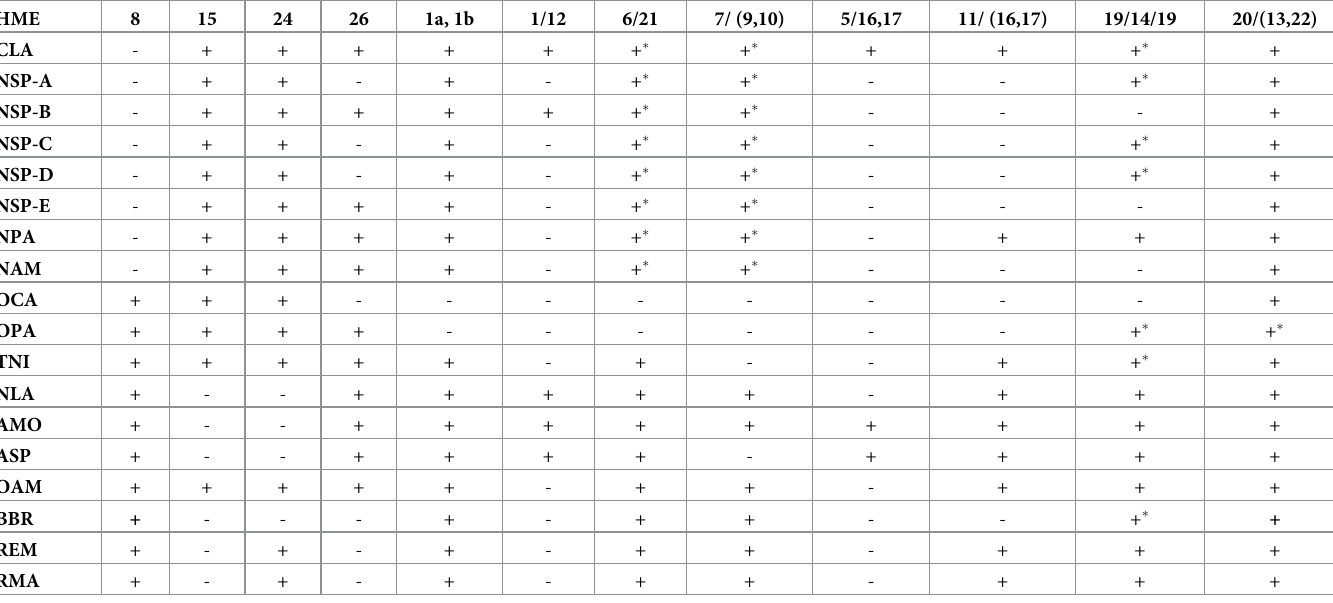
Table 5. Syntenic blocks conserved in the genomes of species that have been hybridized with H . megacephalus probes [32, 39, 40].